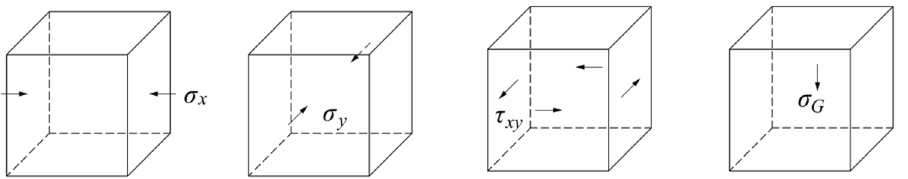
Figure 1. Decomposition of boundary